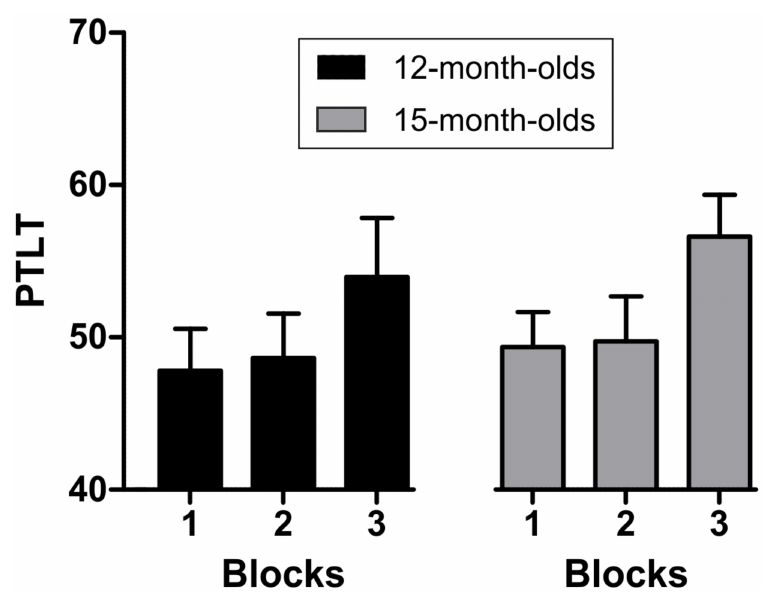
Fig 3. Mean latency (in ms) of first anticipatory look for short and long delays in the first two seconds after the cue in each of the three blocks for each age group. Bars indicate standarderror of the mean.